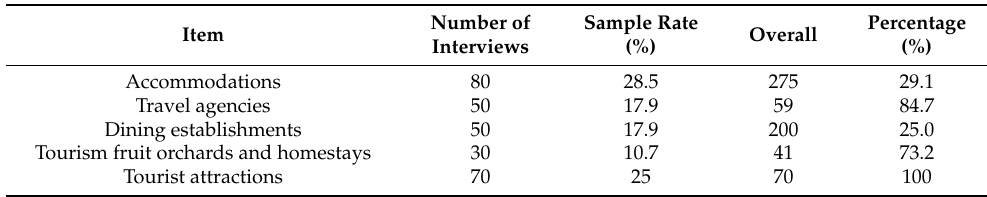
Table 1. Structure of quantitative research